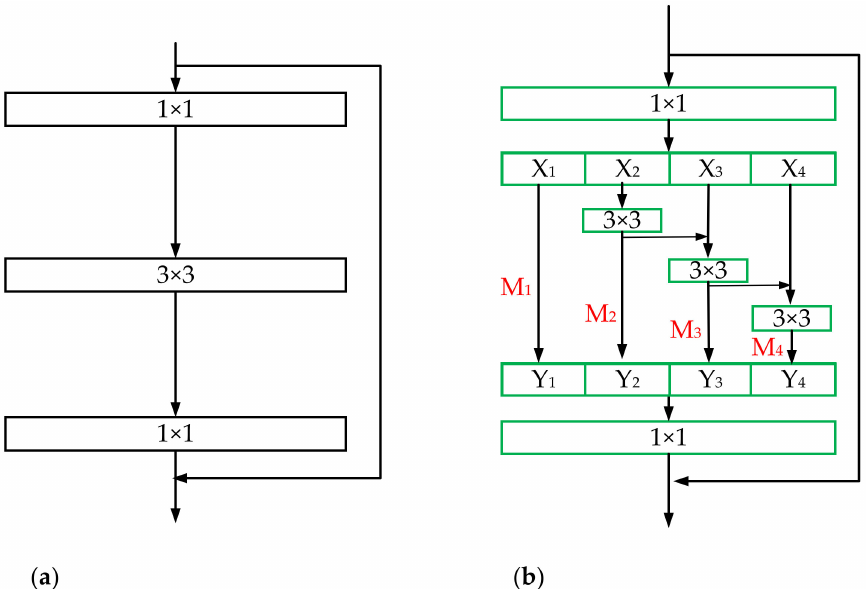
Figure 3. Comparison of ResNet and Res2Net structures. Inside Res2Net, a single 3 × 3 convolution kernel is replaced with a convolution kernel group. ( a ) ResNet module and ( b ) Res2Net